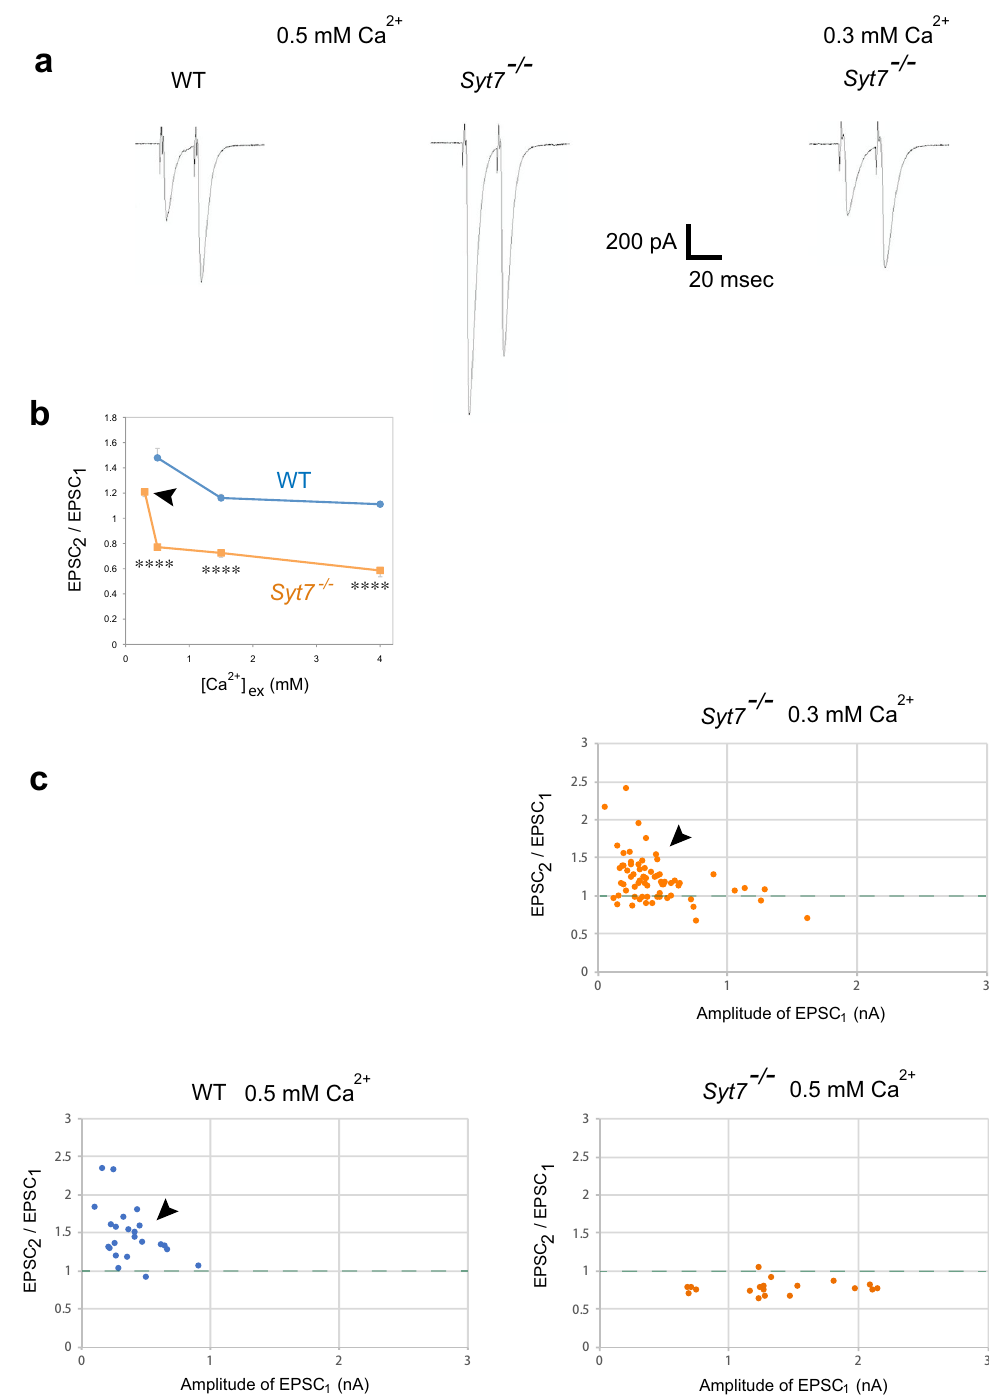
Figure 5. Syt7 suppresses release probability and enables paired-pulse facilitation. ( a ) Representative traces of paired-pulse facilitation with 20 ms intervals in WT and Syt7 −/− at 0.5 mM Ca 2+ and in Syt7 −/− at 0.3 mM Ca 2+ . Twenty sets of responses to paired pulses were averaged. ( b ) Ca 2+ dependence of facilitation ratio as 2nd pulse-induced EPSC (EPSC 2 )/1st pulse-induced EPSC (EPSC 1 ) in WT and Syt7 −/− . Note facilitation at 0.3 mM Ca 2+ in Syt7 −/− (arrowhead). WT and Syt7 −/− were analyzed at each Ca 2+ concentration with Mann–Whitney U test, and significant difference between the two groups was found at 0.5 mM Ca 2+ (****P < 0.0001), 1.5 mM Ca 2+ (****P < 0.0001) and 4 mM Ca 2+ (****P < 0.0001). Ratio at 0.3 mM Ca 2+ in WT was not quantified due to the high probability of failures in response to the 1st pulse. The numbers of samples analyzed for each genotype: (WT) 0.5 mM, 23; 1.5 mM, 10; 4 mM, 10 ( Syt7 −/− ) 0.3 mM, 68; 0.5 mM, 19; 1.5 mM, 11; 4 mM, 13. ( c ) Ratios of EPSC 2 /EPSC 1 at 0.3 mM (only Syt7 −/− ) and 0.5 mM. Responses in ( b ) were plotted with amplitude of EPSC 1 along the X-axis. Note facilitation observed when EPSC 1 is small (arrowheads). Error bars are